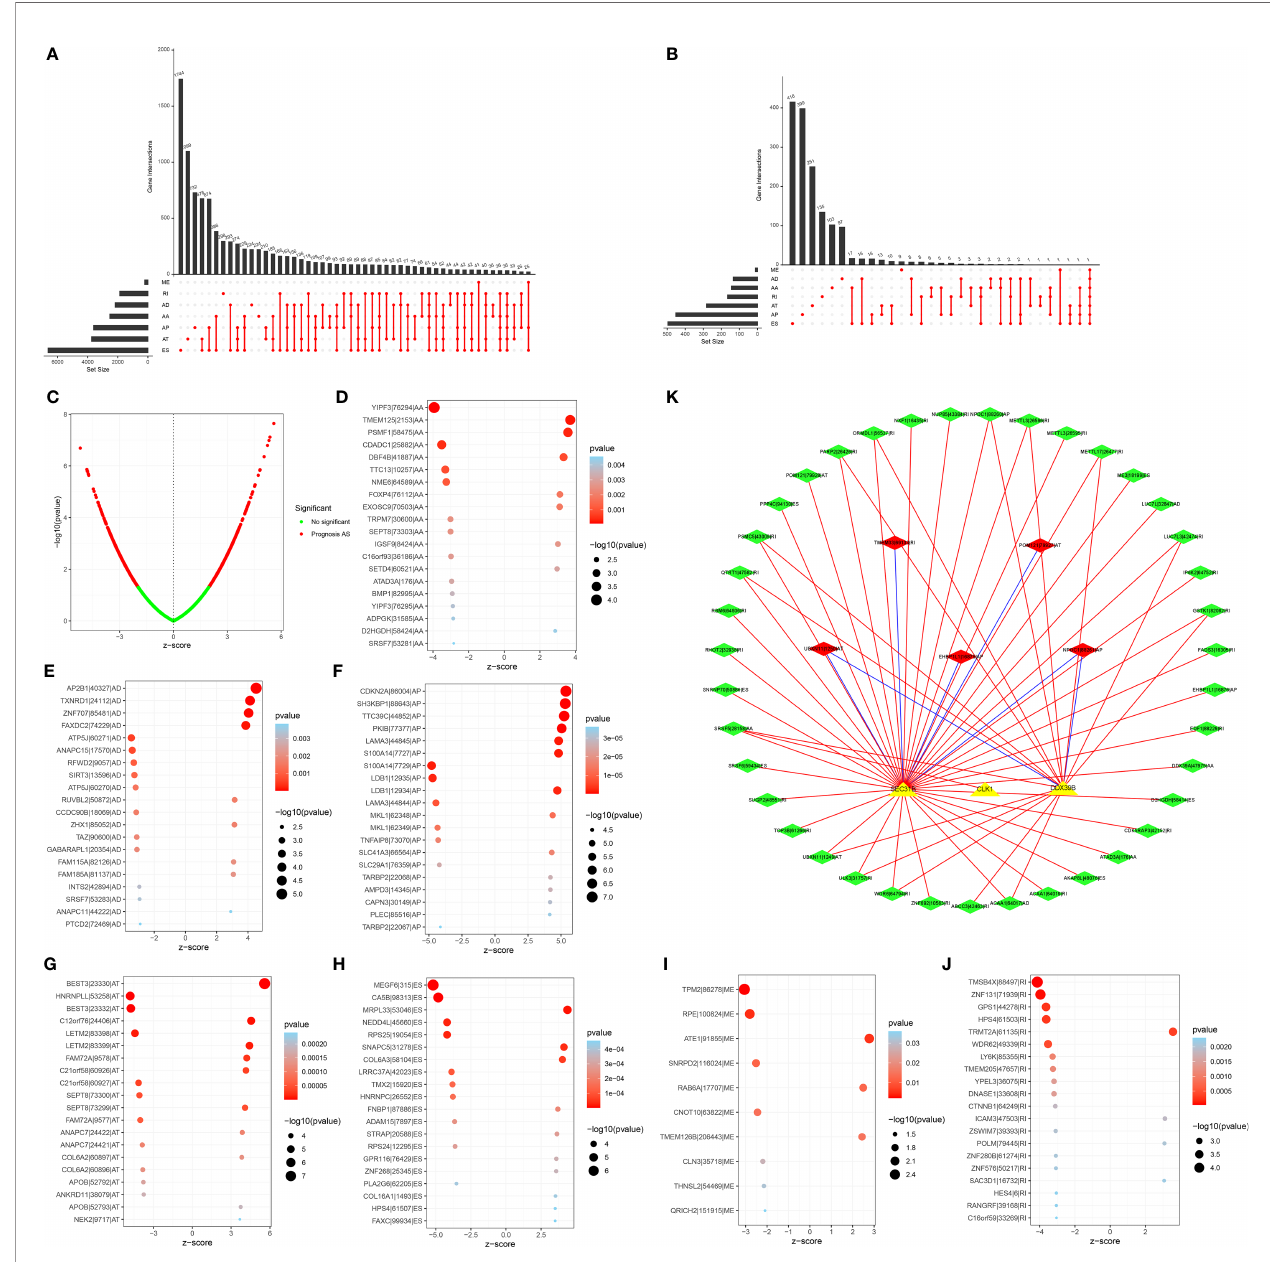
FIGURE 1 | Prognosis-relevant AS events and their interactions with splicing factors across LUAD patients. (A) UpSet plot showing numbers and percentages of AS events as well as their interactions across LUAD specimens. (B) Volcano plots of OS-relevant AS events in LUAD. Red dots represented AS events that were distinctly correlated to OS, but green dots did not affect patients ’ OS. (C) UpSet showing numbers and percentages of seven types of OS-relevant AS events and their interactions in LUAD. (D – J) Bubble plots of the distribution of the fi rst 20 most signi fi cant AS events in LUAD, which indicated that the seven alternative splicing modes exhibit great variability. (K) The OS-relevant splicing factor-AS interaction network in LUAD. Triangle bubbles indicated splicing factors and diamond bubbles indicated AS events. The red and blue line separately indicated positive and negative connection in splicing factors and AS events. Red and green diamond bubbles separately meant adverse and favorable prognosis-relevant AS